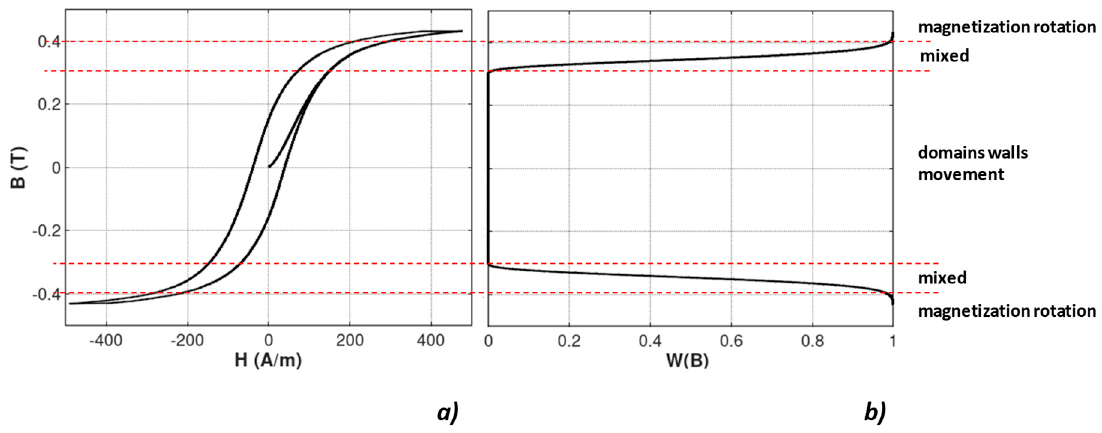
Figure 1. Changes in the mechanism of magnetization in Mn 0.70 Zn 0.24 Fe 2.06 O 4 ferrite for power applications: ( a ) Magnetic hysteresis loop B ( H ); ( b ) W ( B ) dependence determining the mechanism of magnetization.